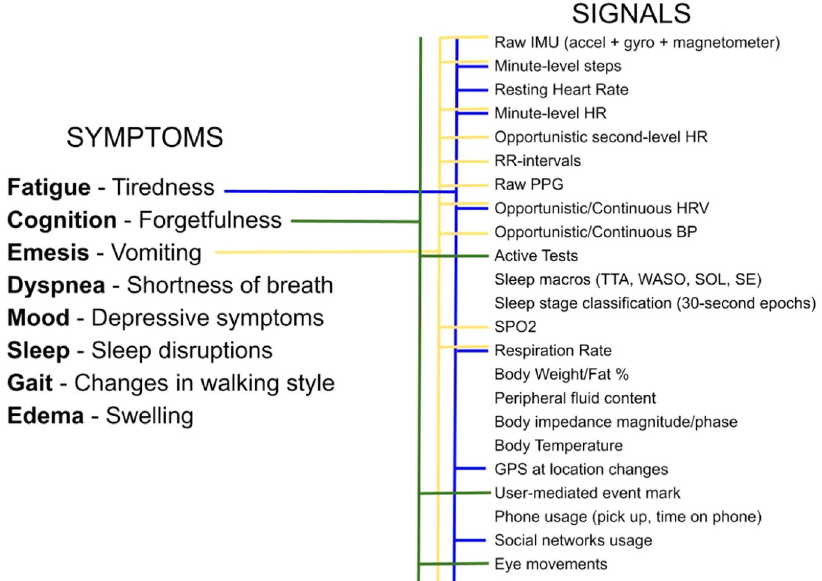
Fig. 1 Pregnancy-related symptoms to objectively measured signals. A spider chart of pregnancy-related symptoms and their potential objective signals from digital